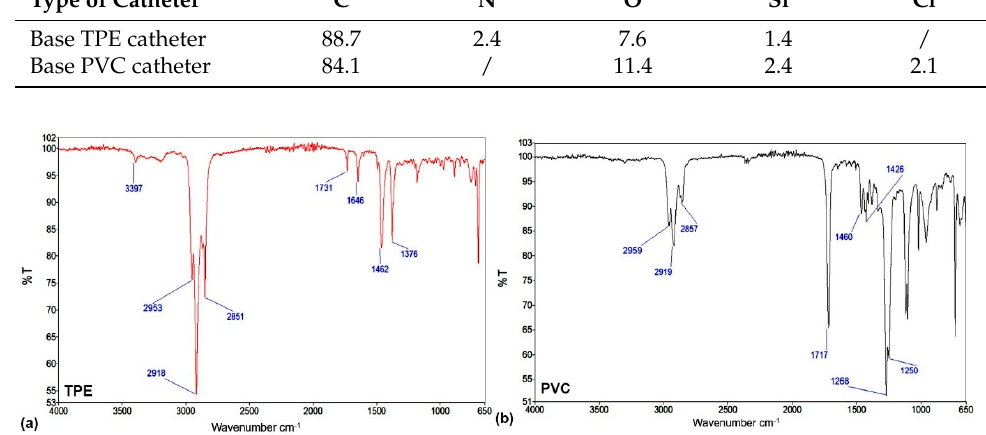
Table 1. XPS surface composition of as-received urinary medical catheters (atomic %). Type of Catheter